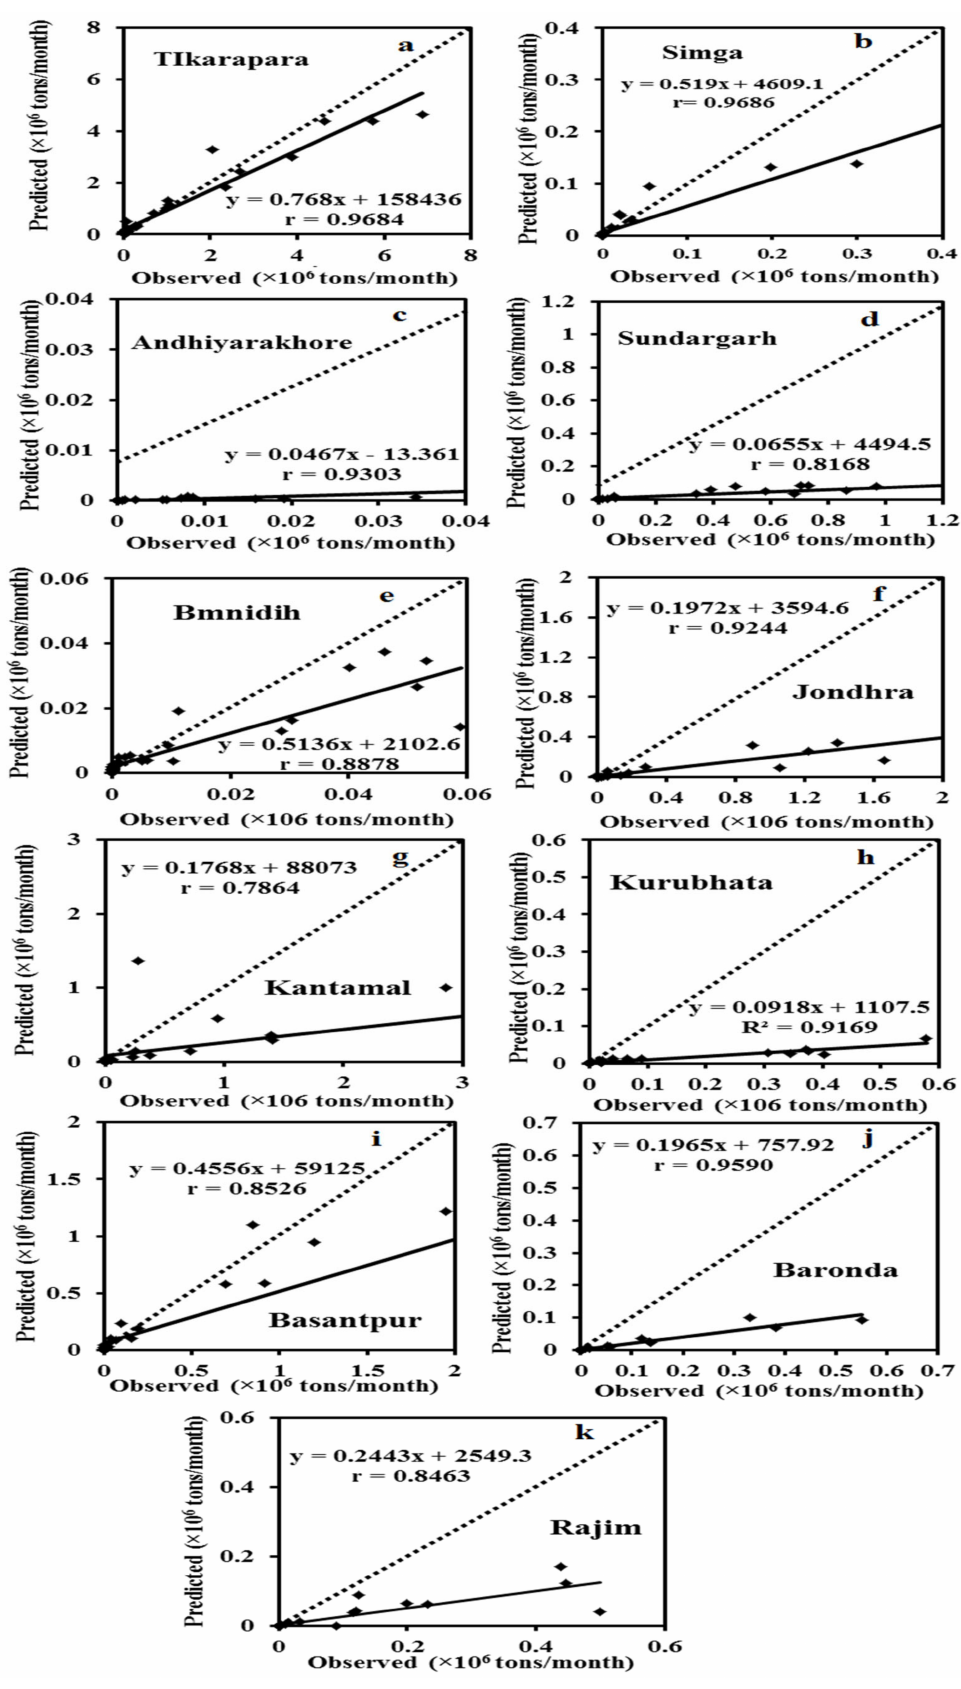
Figure 13. Scatter between the predicted and actual SSY of testing data of the SRC